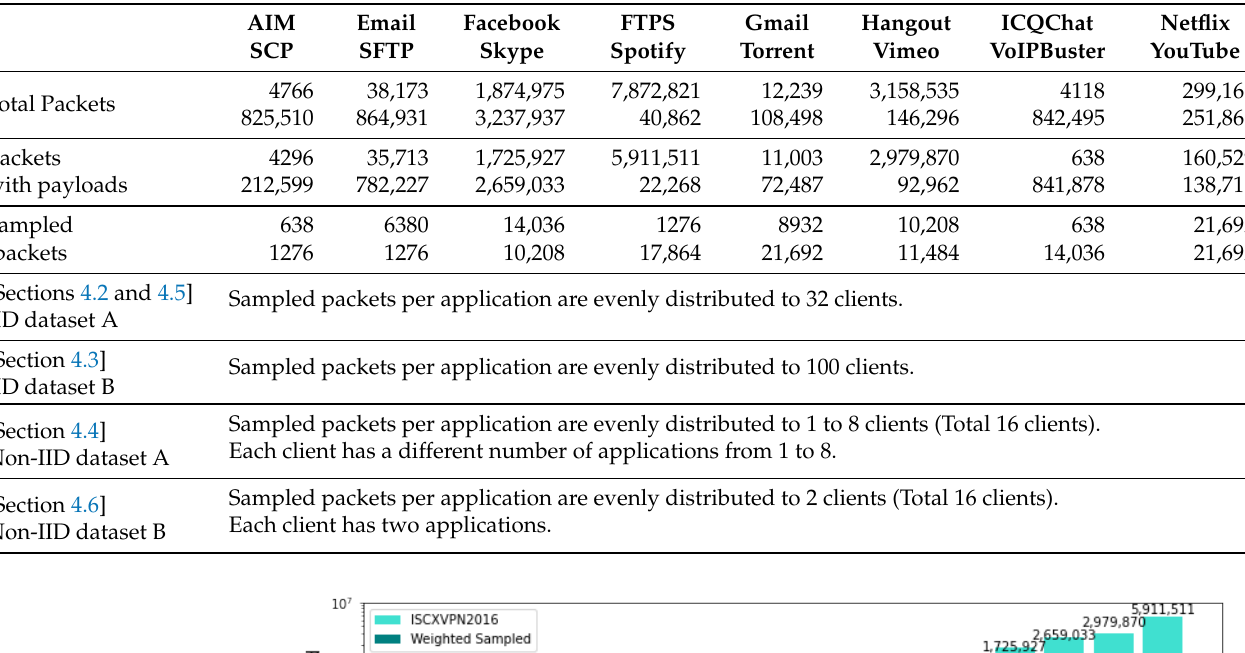
Table 2. Datasets for experiments (16 applications).